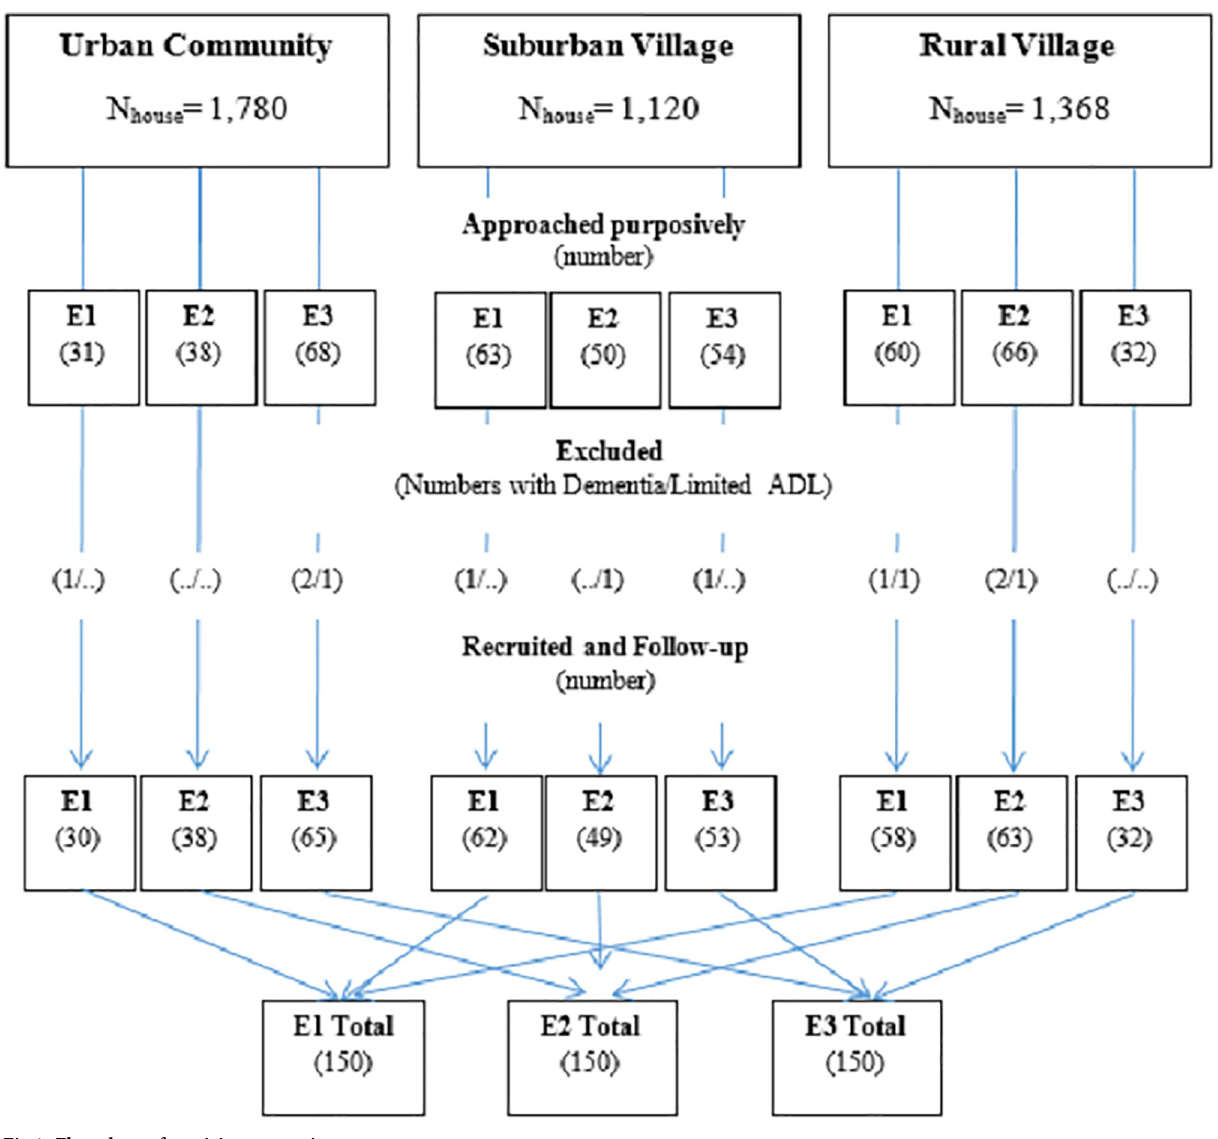
Fig 1. Flow chart of participant